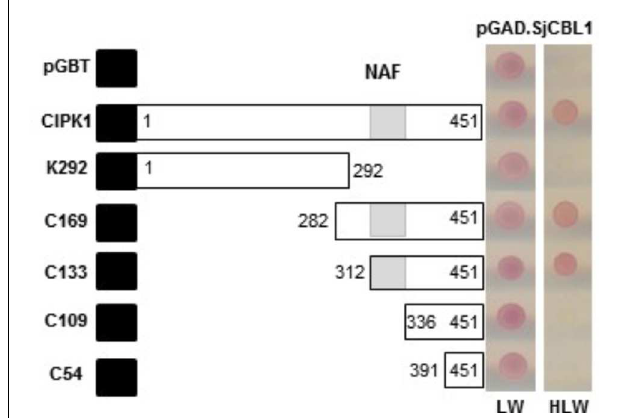
FIGURE 5 | Determination of the CIPK1 region responsible for the interaction with SjCBL1. A series of SjCBL1 deletion mutants were created in the pGBT vector and cotransformed into the Y190 yeast cells with pGAD · SjCBL1. Numbers in the white boxes indicate the beginning and the ending positions of each protein fragment. Black and shaded boxes denote the DNA-binding domain of the GAL4 transcription factor and NAF domain, respectively. Two panels on the right display yeast growth on synthetic complete medium lacking Leu and Trp (SC-LW) and synthetic complete medium lacking His, Leu, and Trp (SC-HLW), respectively.